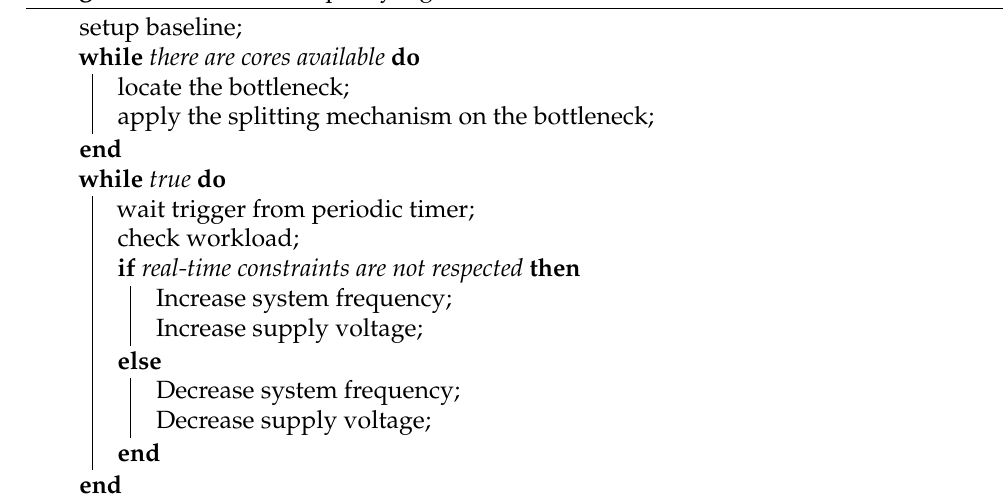
Algorithm 1: ADAM-FF policy